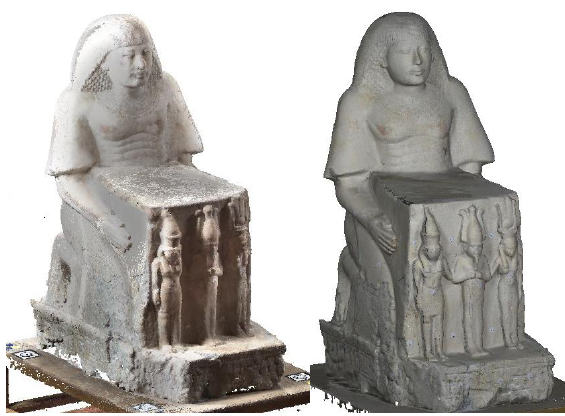
Figure 3. Laser Freestyle point cloud and textured mesh.